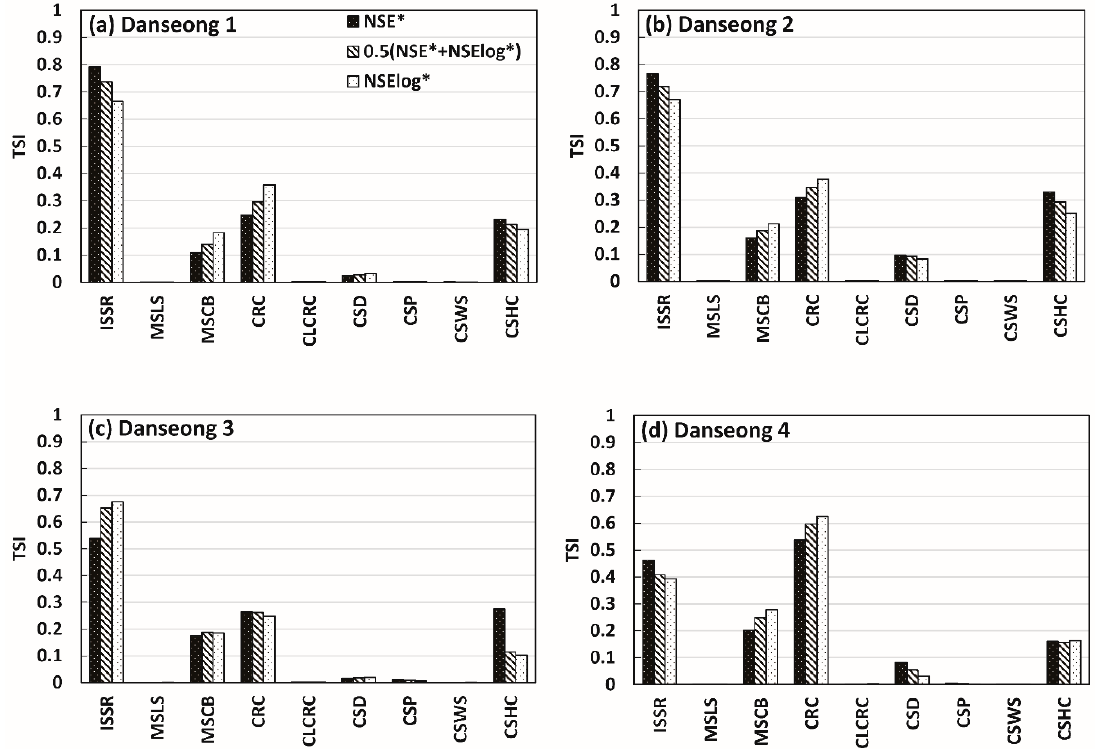
Figure 6. Parameter sensitivity of the four rainfall events in Danseong catchment, calculated for the three objective functions: ( a ) Danseong 1; ( b ) Danseong 2; ( c ) Danseong 3; ( d ) Danseong 4.